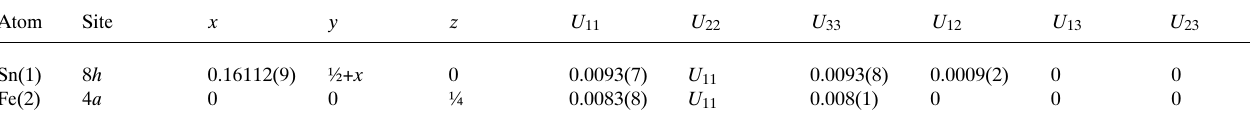
Table 2. Atomic coordinates and displacement parameters (in Å 2 ) .